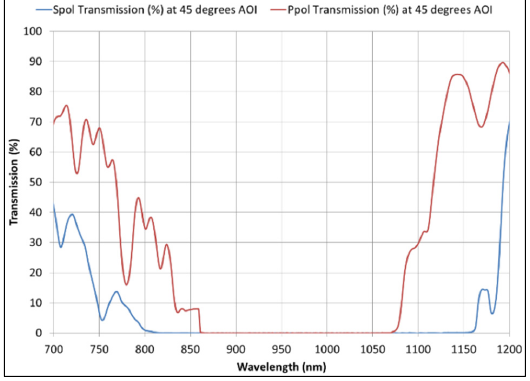
Figure 10. Measured Transmission spectra at 45° AOI for Ppol and Spol for the initial BBHR test coating.